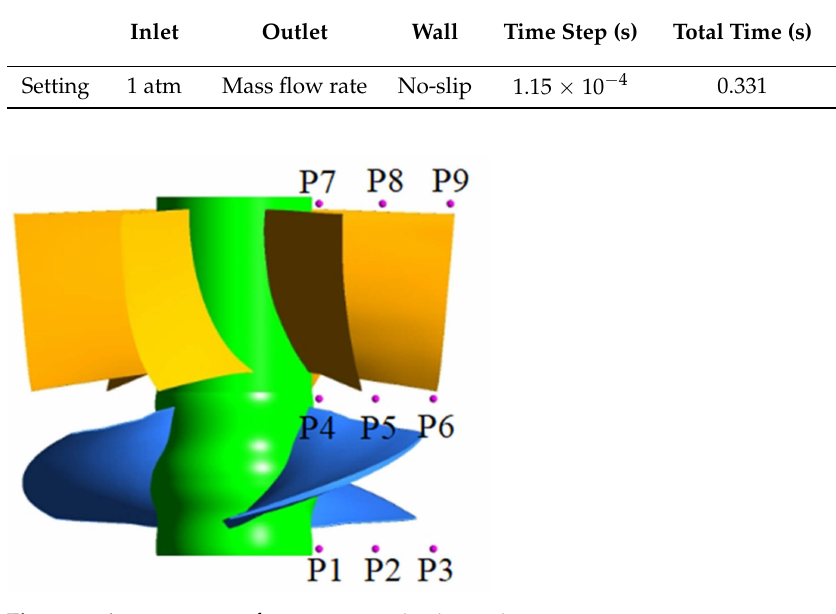
Figure 2. Arrangement of pressure monitoring points.